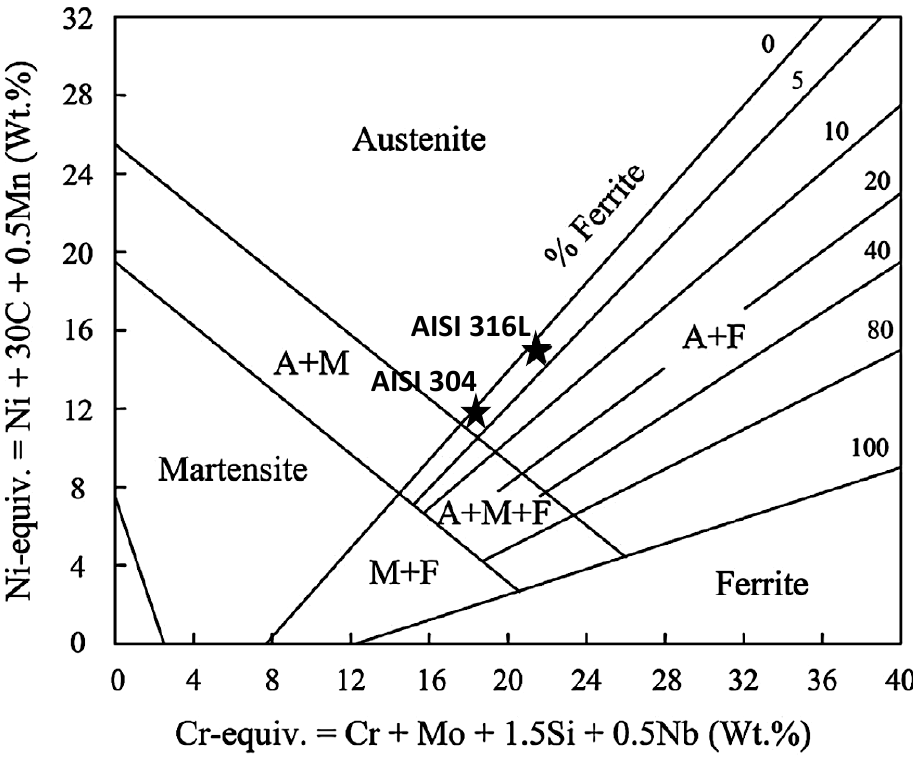
Figure 1. The Schaeffler diagram for Fe–Cr–Ni stainless steel structure predictions in welds. Modified from [2]. According to Masiasz and Busby [5], the steels shown in Table 1 that have added Mo (316) or are stabilised with Ti (321) or Nb (347) also have reasonably good elevated tem- perature strength and creep resistance. Stainless steels are primarily composed of Fe, Cr and Ni and occupy a narrow section of the Fe–Cr–Ni phase diagram at 400 °C, outlined in green in Figure 2. The FCC austenite γ-phase is the main phase of austenitic stainless steels, as the name states, although there may be a small volume of BCC α-ferrite phase, especially after welding. Because most reactor-grade stainless steels contain between 10 and 30 wt% Ni, they have large volume fractions of austenite phase and have properties closer to that of Ni alloys rather than the low-alloy body-centred-cubic (BCC) ferritic steels. Although they do not contain high con- centrations of Ni, the effect of Ni in promoting He production in austenitic stainless steels can still be important, especially when the thermal neutron flux is high.